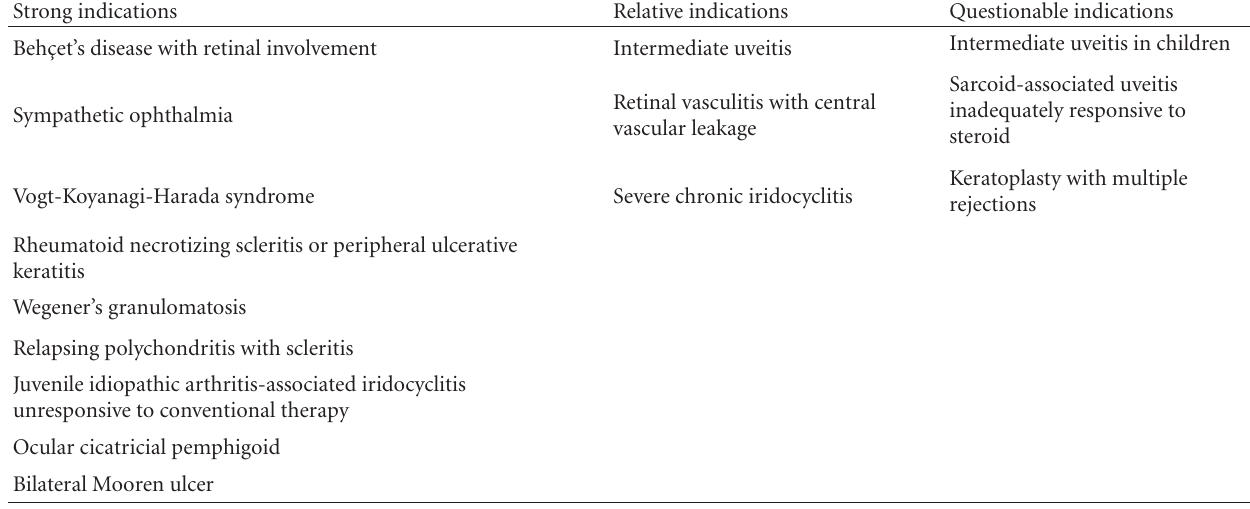
Table 1: Diseases indicated for immunosuppressive chemotherapy.